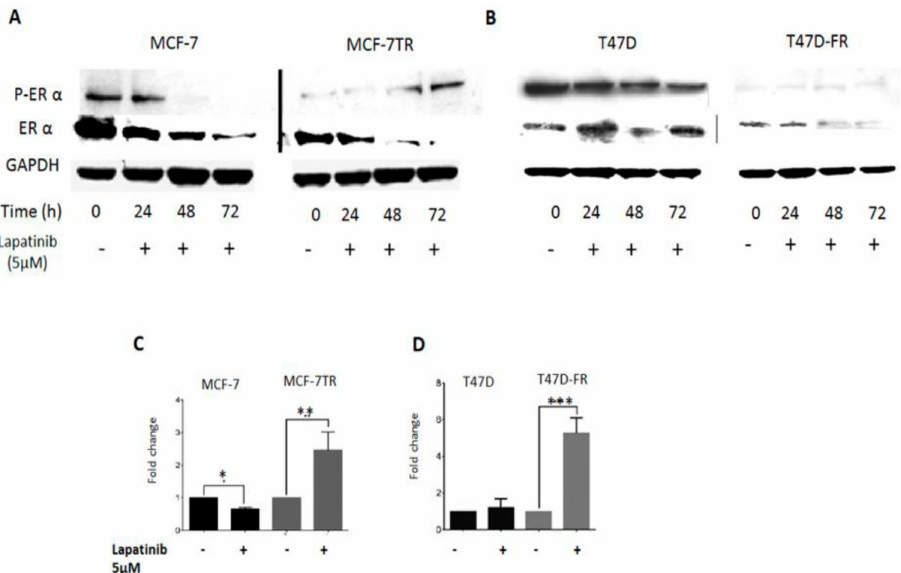
Figure 6. Oestrogen receptor- α (ER α ) re-activation following treatment of anti-oestrogen-resistant breast cancer cell lines with lapatinib. ( A , B ) Representative Western blots of ER α and activated pER α at time points up to 72 h for MCF-7 and T47D cell lines, respectively. Representative Western blot data obtained from whole-cell lysates (upper panel) separated by SDS-PAGE, immunoblotted onto PVDF membranes before immunodetection ( n = 3). ( C , D ) Levels of fold change in ESR mRNA as measured by qPCR and corrected to GAPDH as the housekeeping gene, using the ∆∆ C t equation. Expression in MCF-7 ( C ) and T47D ( D ) parental cell line control (untreated) values were normalised to 1.0. Statistical analysis was performed using a two-tailed t -test: * p < 0.05; ** p <